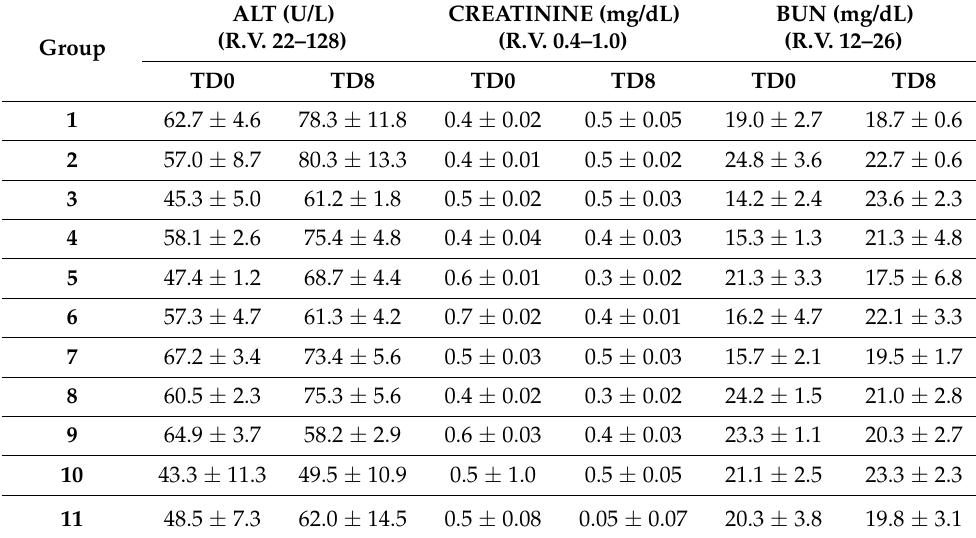
Table 4. Changes of the serum levels of alanine transaminase (ALT), blood urea nitrogen (BUN) and creatinine in golden hamsters before and after treatment with Arnica tincture and other topical formulations as well as meglumine antimoniate. Data represent means ± SD for each group of hamsters. R.V.: reference